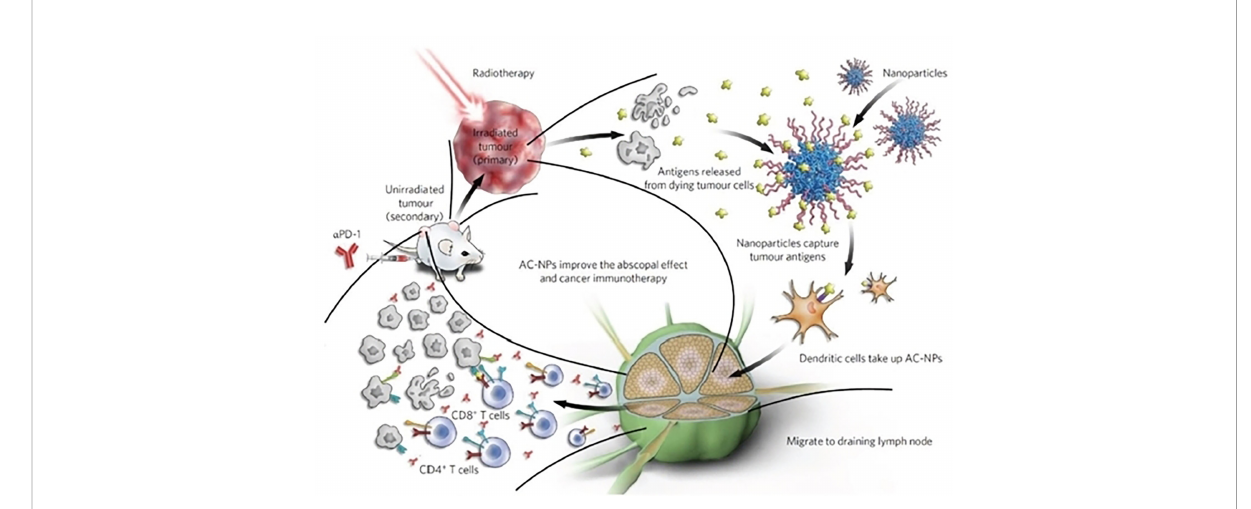
FIGURE 8 Schematic illustration of antigen-capture nanoparticles used for tumor immunotherapy. Reproduced with permission from Ref (116). Copyright 2017, Nature Publishing